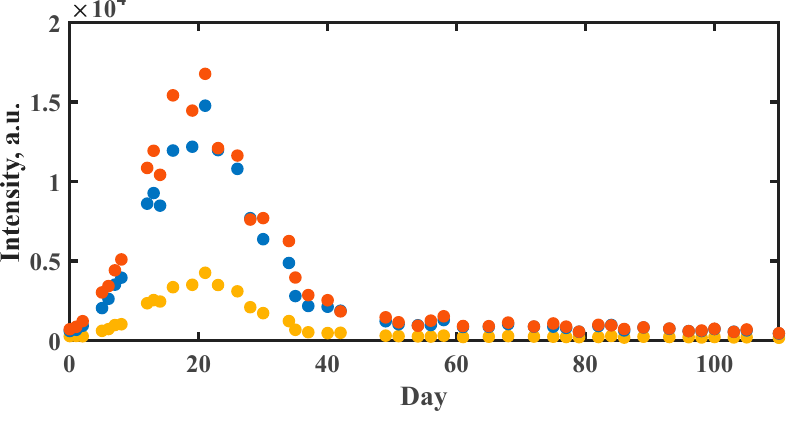
Figure 3. Ripening process of hot peppers as observed through the averaged signal intensity at 1001 (yellow), 1156 (blue) and 1515 cm − 1 (orange) in the Raman spectra of three immature, harvested fruits.